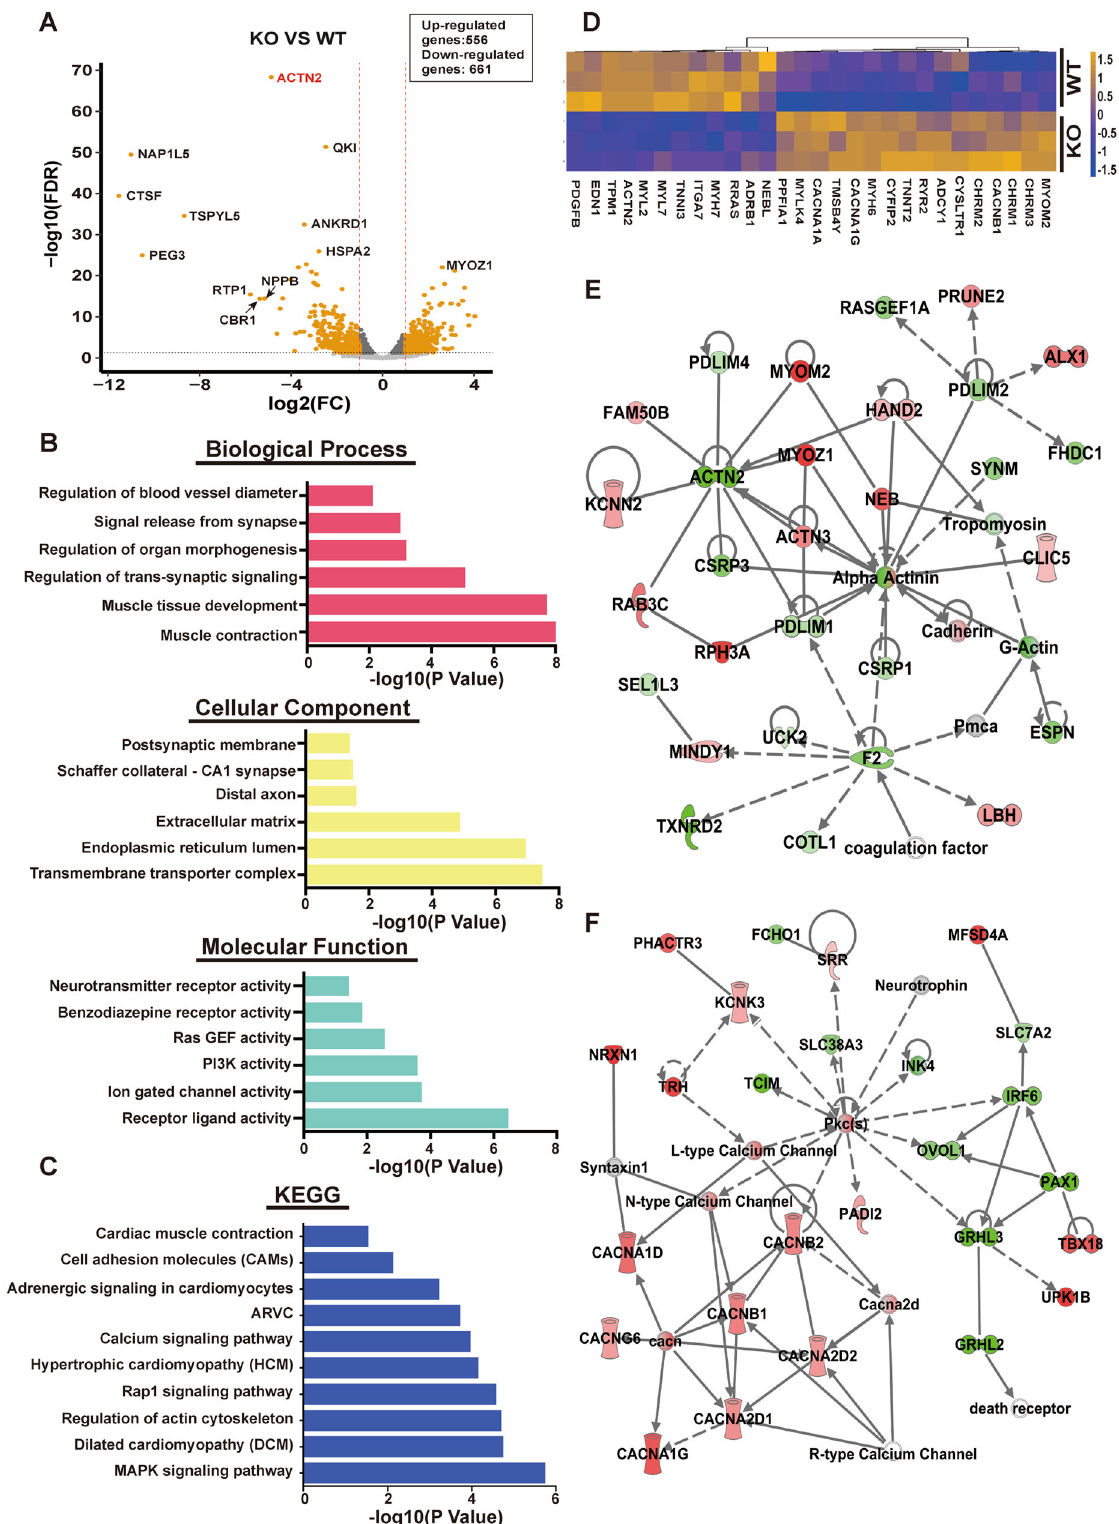
sigma; SML1538) to hCM- QKI del , a speci fi c inhibitor disrupting the interaction of UPF1 and SMG7 in the NMD pathway 64 . We found that ACTN2 SE-8 mRNA levels were signi fi cantly enriched in NMDI14-treated cells (Fig. 6D, right panel), indicating that this rapid degradation of ACTN2 SE-8 mRNA in hCM- QKI del was in fact due to the activation of the NMD pathway.